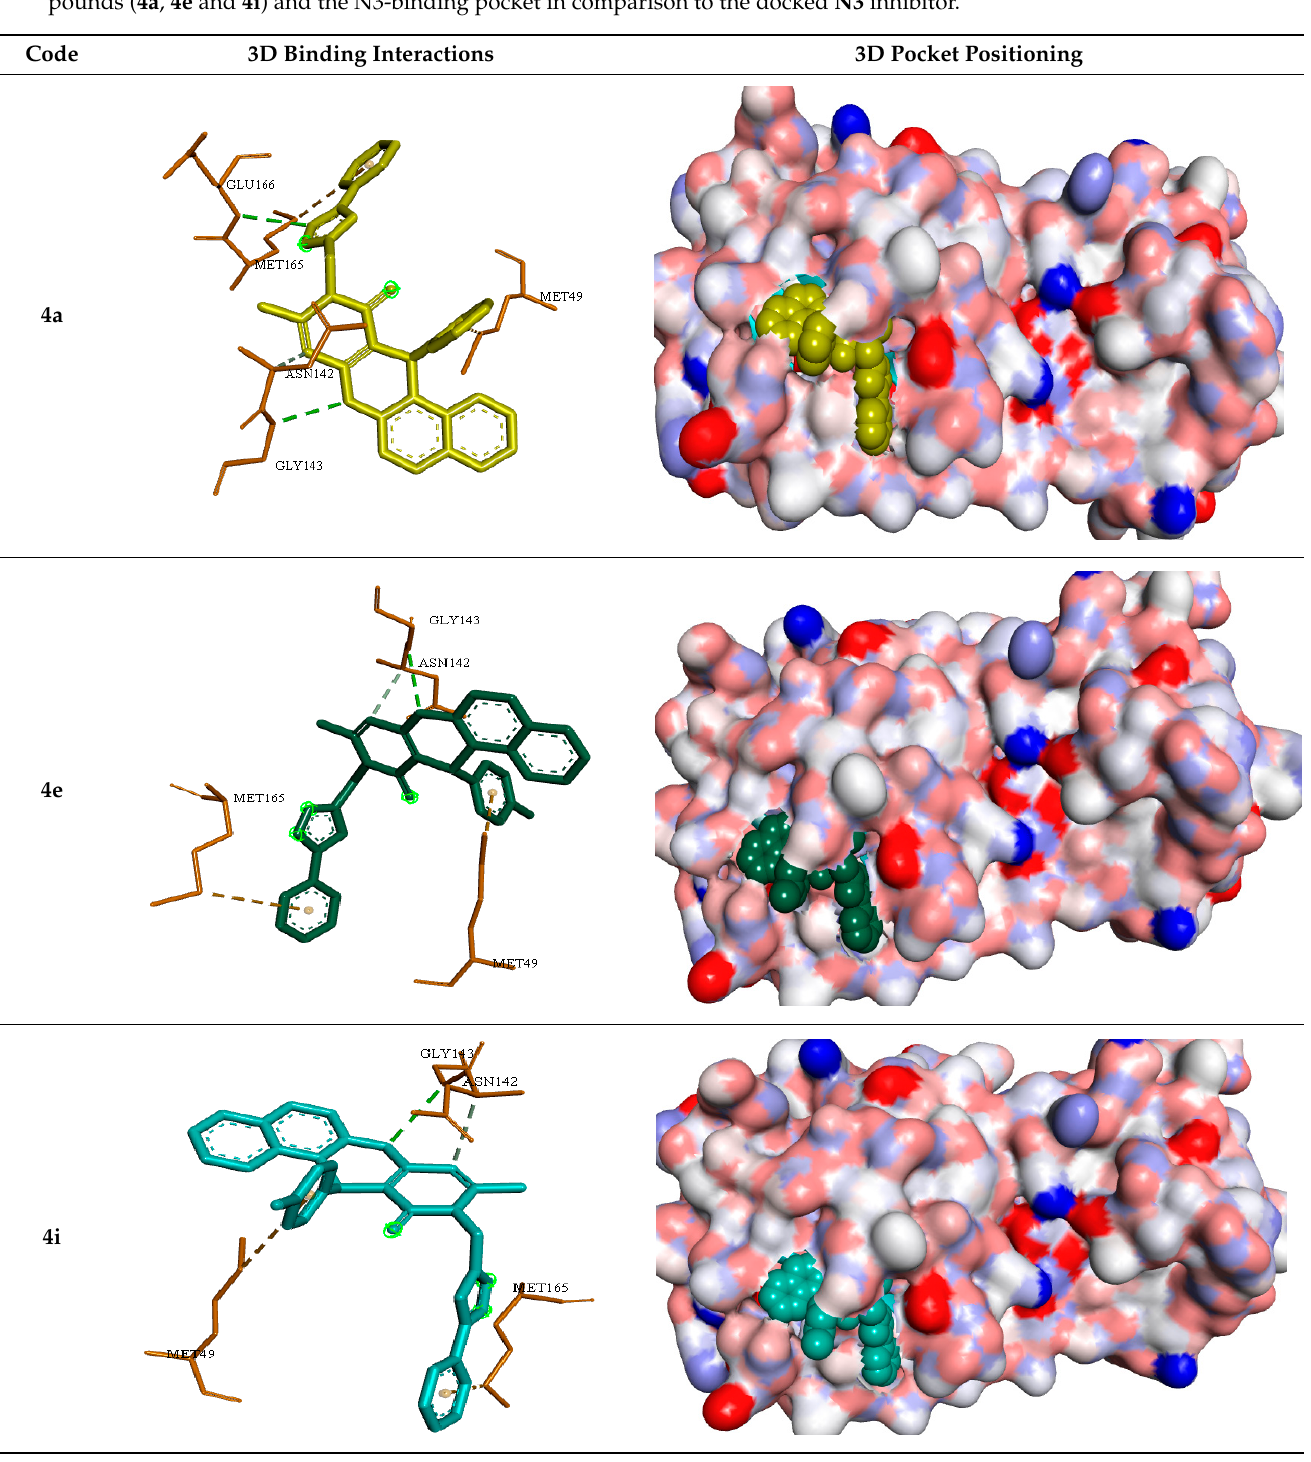
Table 4. 3D representations showing the binding interactions and positioning between the three promising tested com- pounds ( 4k , 4h and 4j ) and the N3 -binding pocket. Code 3D Binding Interactions